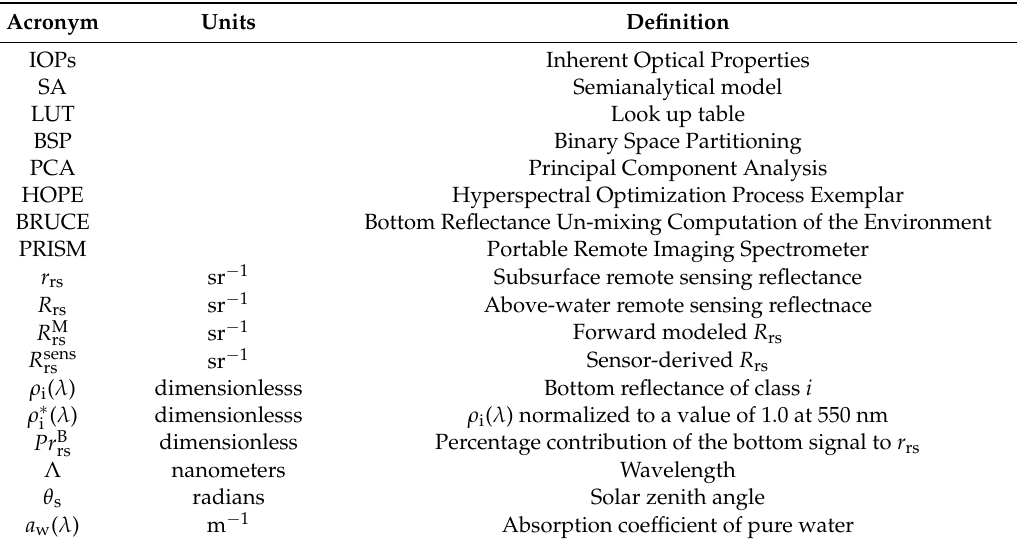
Table 1. The relevant acronyms and symbols and their